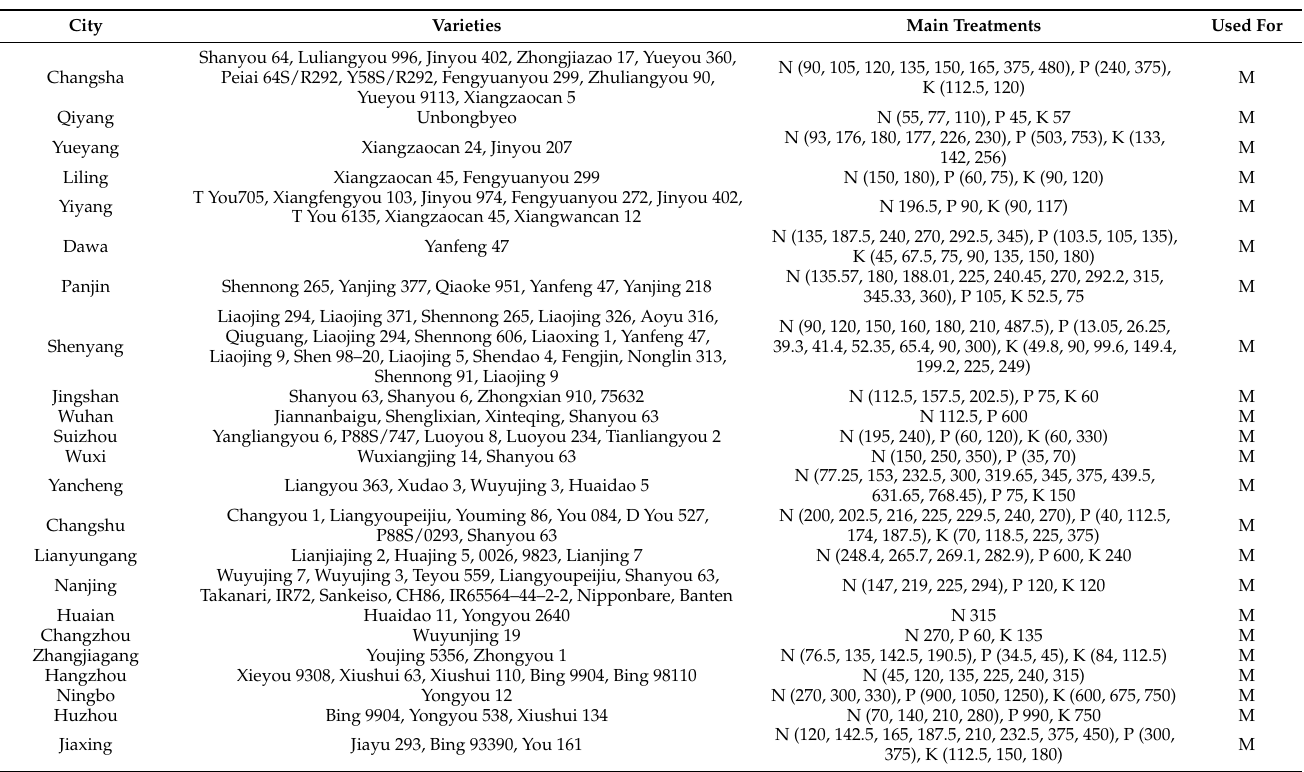
Table 6. Varieties and Main Treatments at Each Site for Rice in China. N, N fertilisation (kg · hm − 2 );